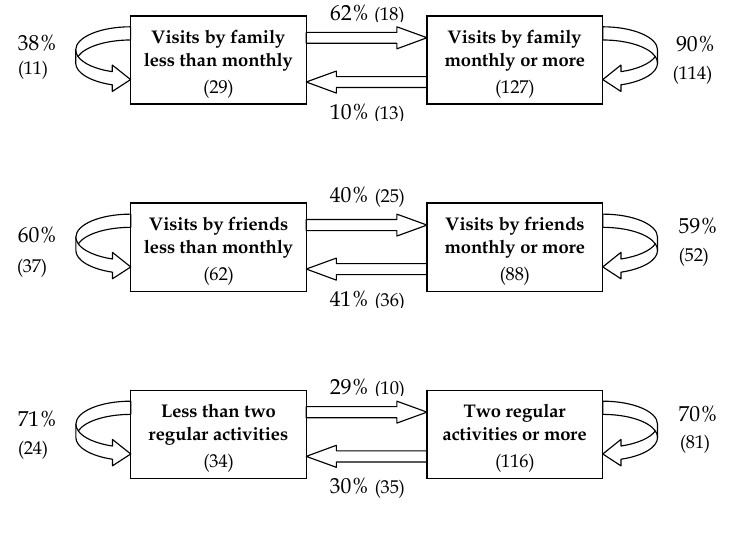
Figure 1 . Change between W 1 and W 5 in number of visits received by individuals and in their sociability activities (survivors in W 5 , n = 157